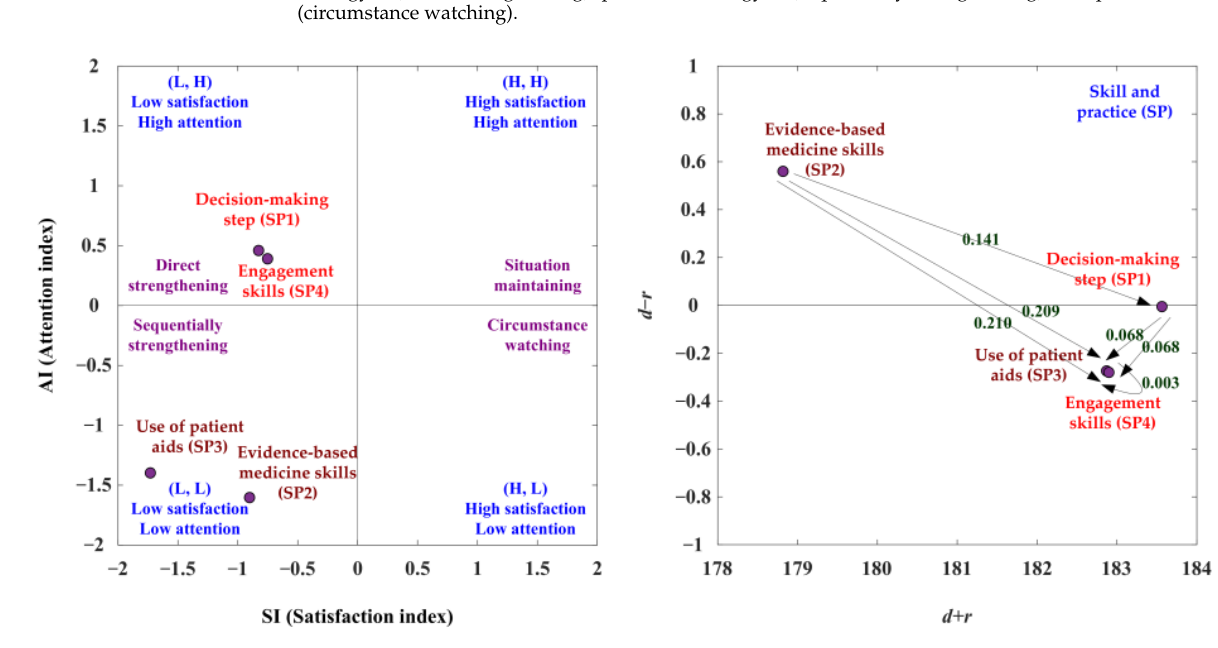
Figure 4. The SDM competency development map for the SP (skill and practice) aspect. Table 10. The net influence matrix of SP (skill and practice) aspect.